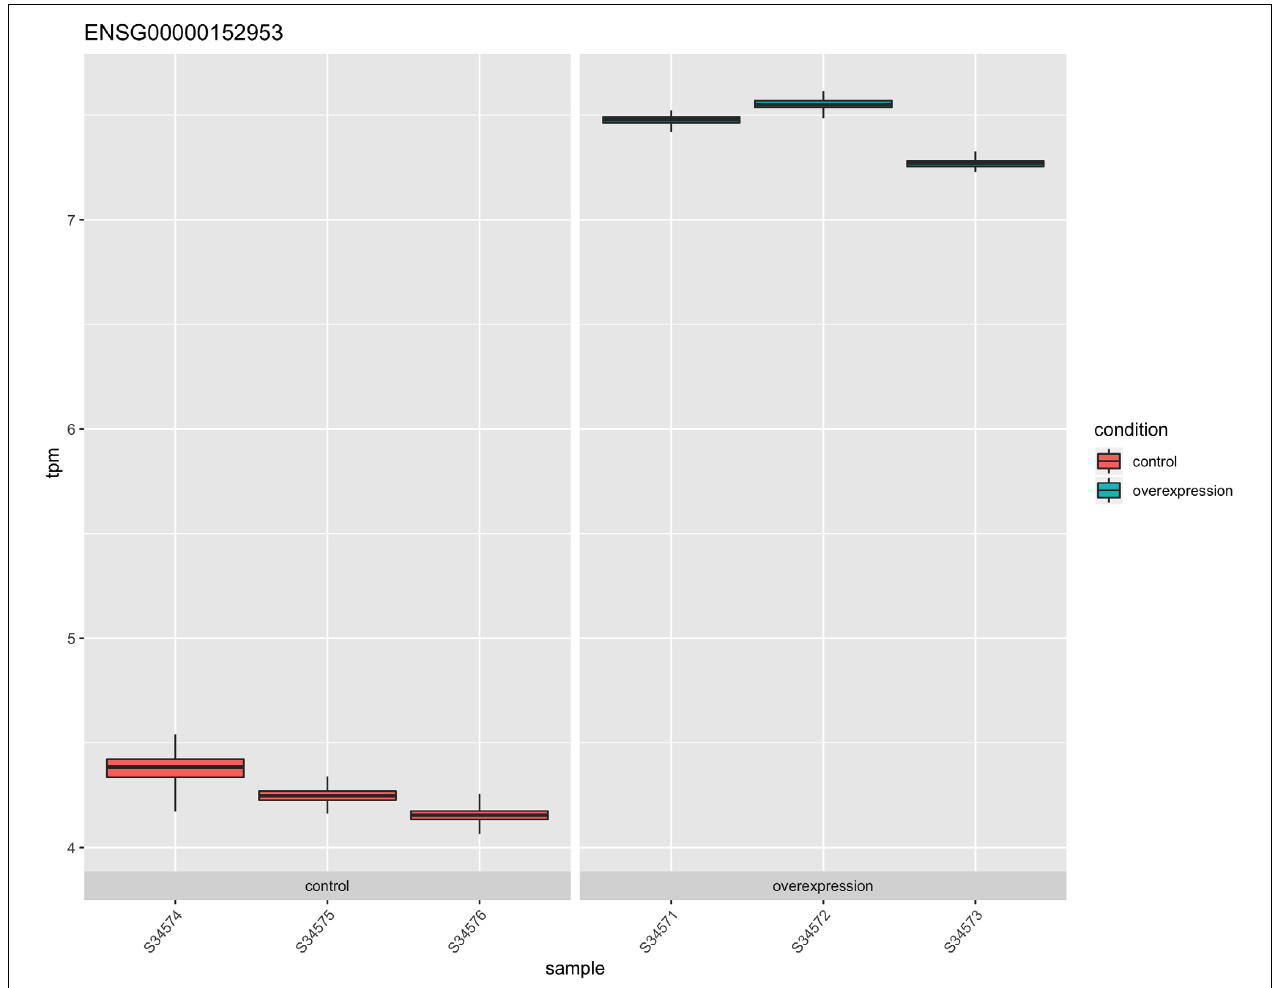
FIGURE 1 | The RNA expression of STK32B overexpressed cells compared to empty-vector controls based on RNA sequencing data. Error bars show the technical variance determined with 200 bootstraps. TPM, transcript per